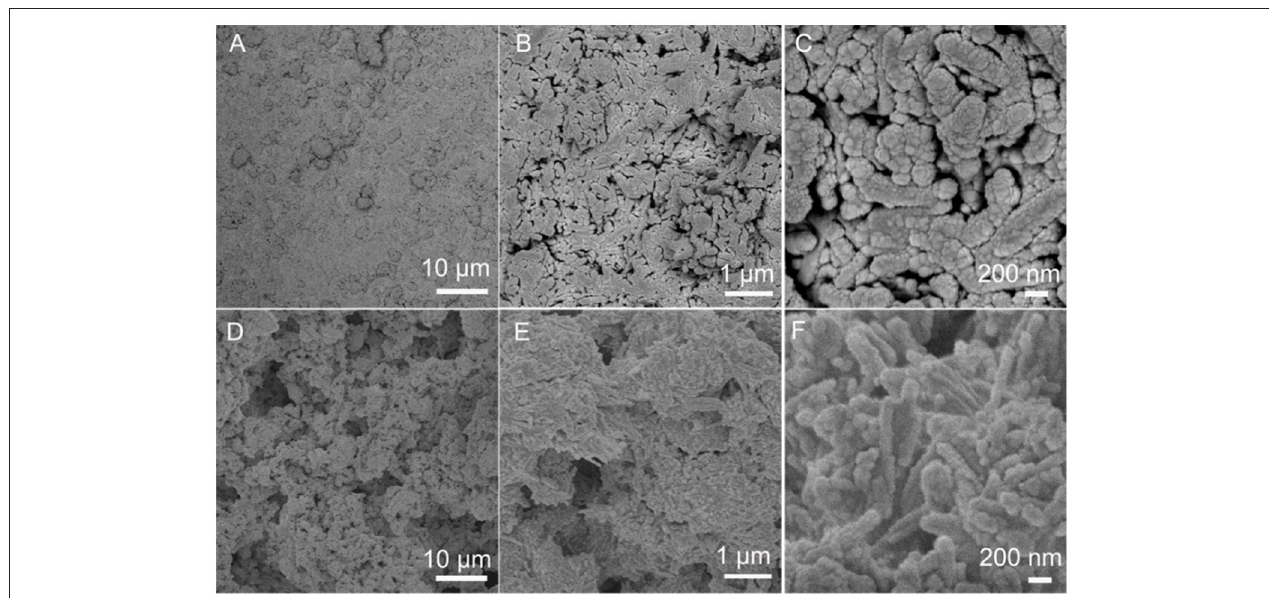
FIGURE 2 | SEM images of (A – C) PAL/IOR coating and (D – F) PAL/IOR@fluoroPOS coatings. C PAL / IOR = 14g L − 1 , t grinding = 20min, C PFDTES = 27.2mM, C TEOS =